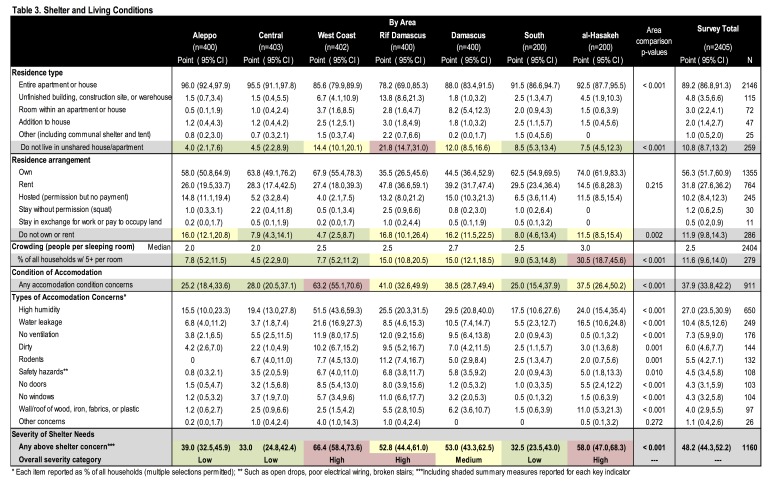
Table 3. Shelter and Living Conditions